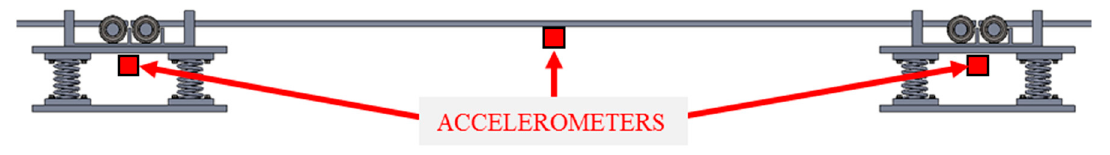
Figure 7. Accelerometer locations.